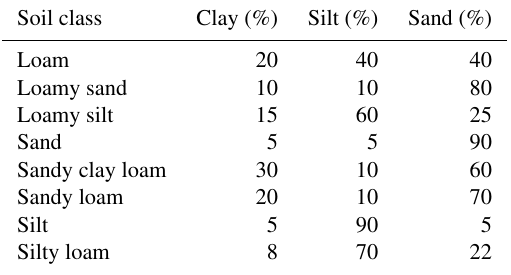
Table 3. Percentage (%) of sand, silt, and clay of the centroid of relevant soil textural classes within the USDA soil texture